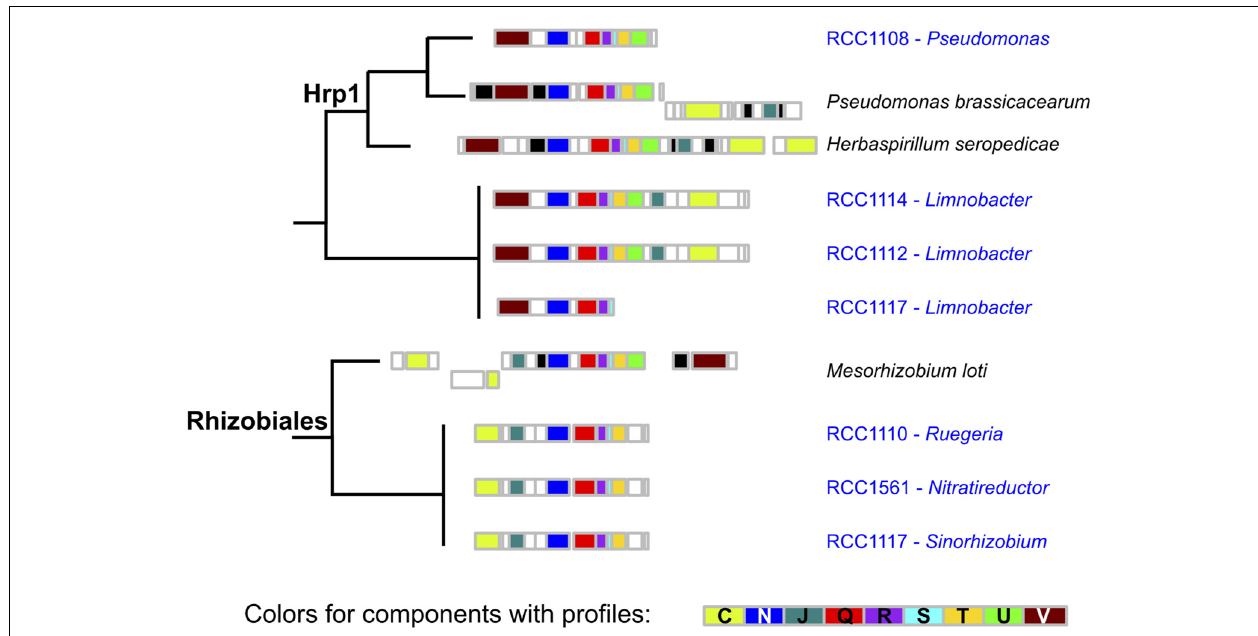
FIGURE 3 | Genetic architecture of microbiomeT3SS. The genetic architecture ofT3SS detected in microbiomes’ contigs and of the closest systems found in a complete genome is displayed along the corresponding phylogeny.The color of boxes corresponds to the colors in Figure 1